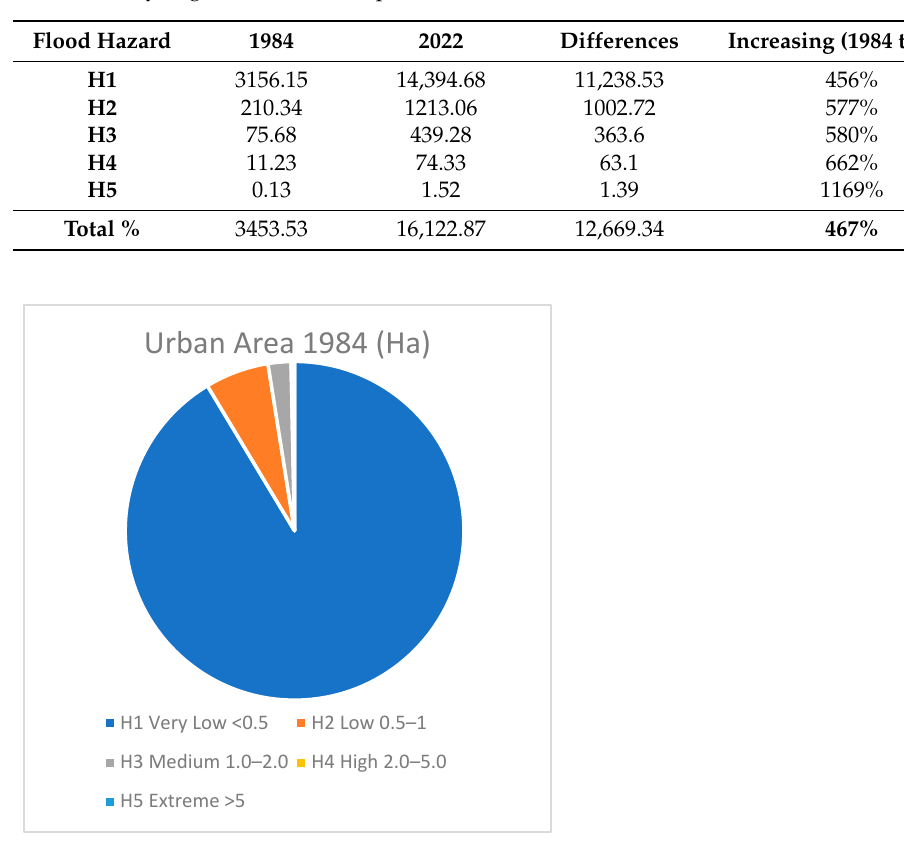
Table 7. Analyzing of urban areas exposure between 1984 and 2022.